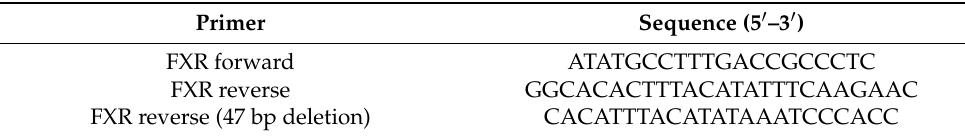
Table 2. Primers for